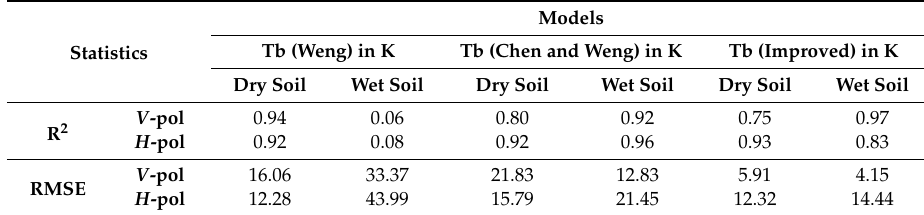
Table 5. Statistics for comparisons between the simulated and measured brightness temperatures ( Tb : brightness temperature in K ) using the Weng, Chen and Weng, and parameterized soil-surface emissivity models ( V -pol: vertical polarization, H -pol: horizontal